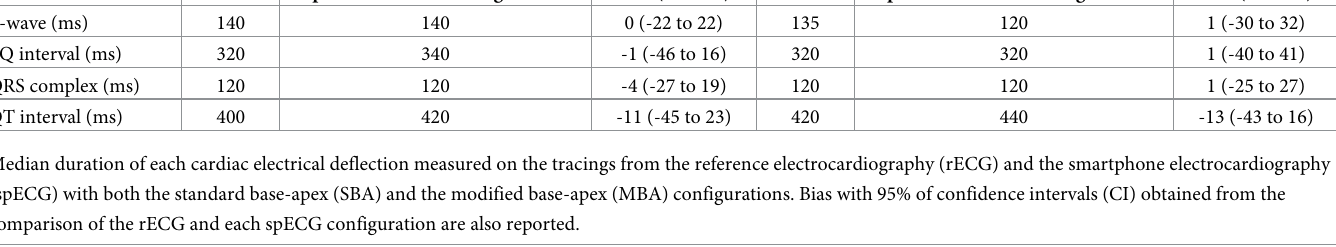
comparison of the rECG and each spECG configuration are also reported.